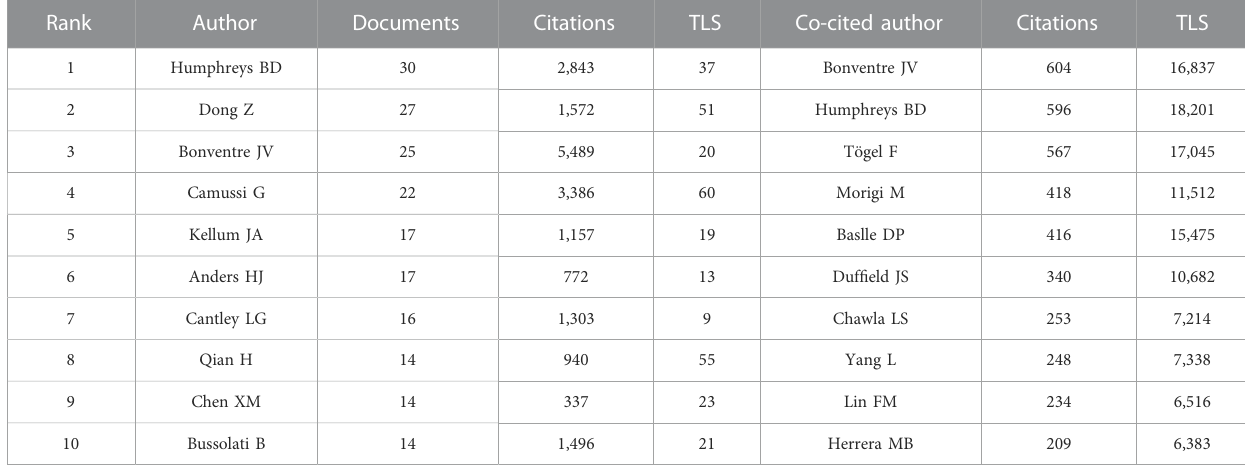
TABLE 3 Top 10 authors and co-cited authors in the fi eld of AKI in kidney